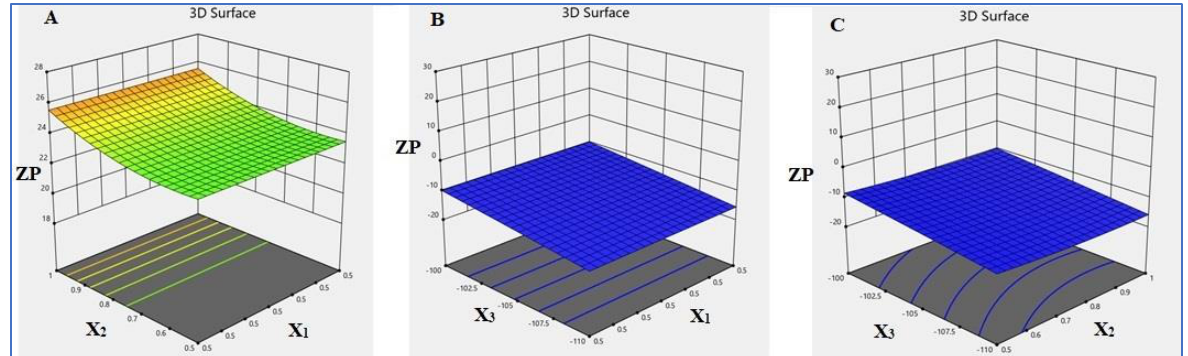
Figure 3. Three-dimensional-response surface plot showing effect of independent variables ( A ) X 1 and X 2 ; ( B ) X 1 and X 3 ; and ( C ) X 2 and X 3 on ZP.